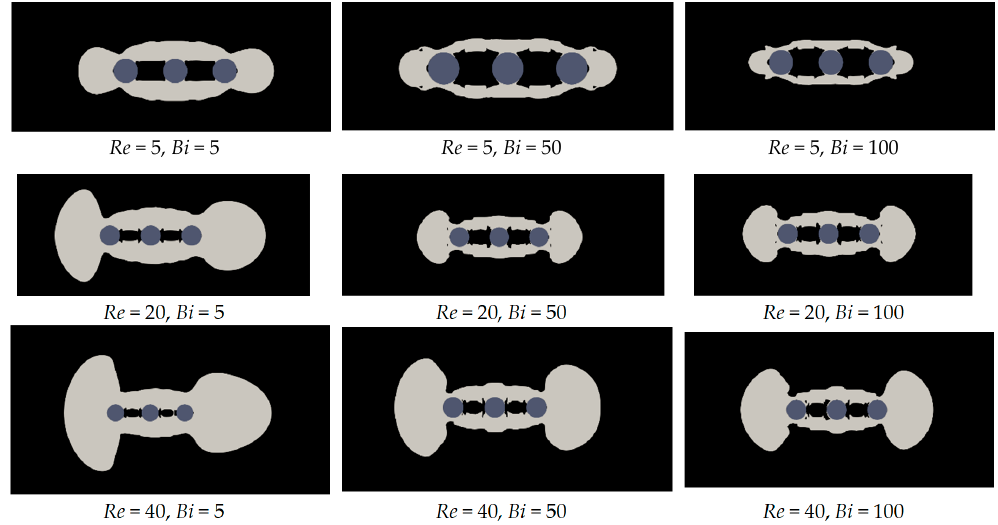
Figure 7. Progressive growth of the unyielded region (shaded) with the increasing Bingham number and decreasing Reynolds number where separation distance d = 2.0 D .